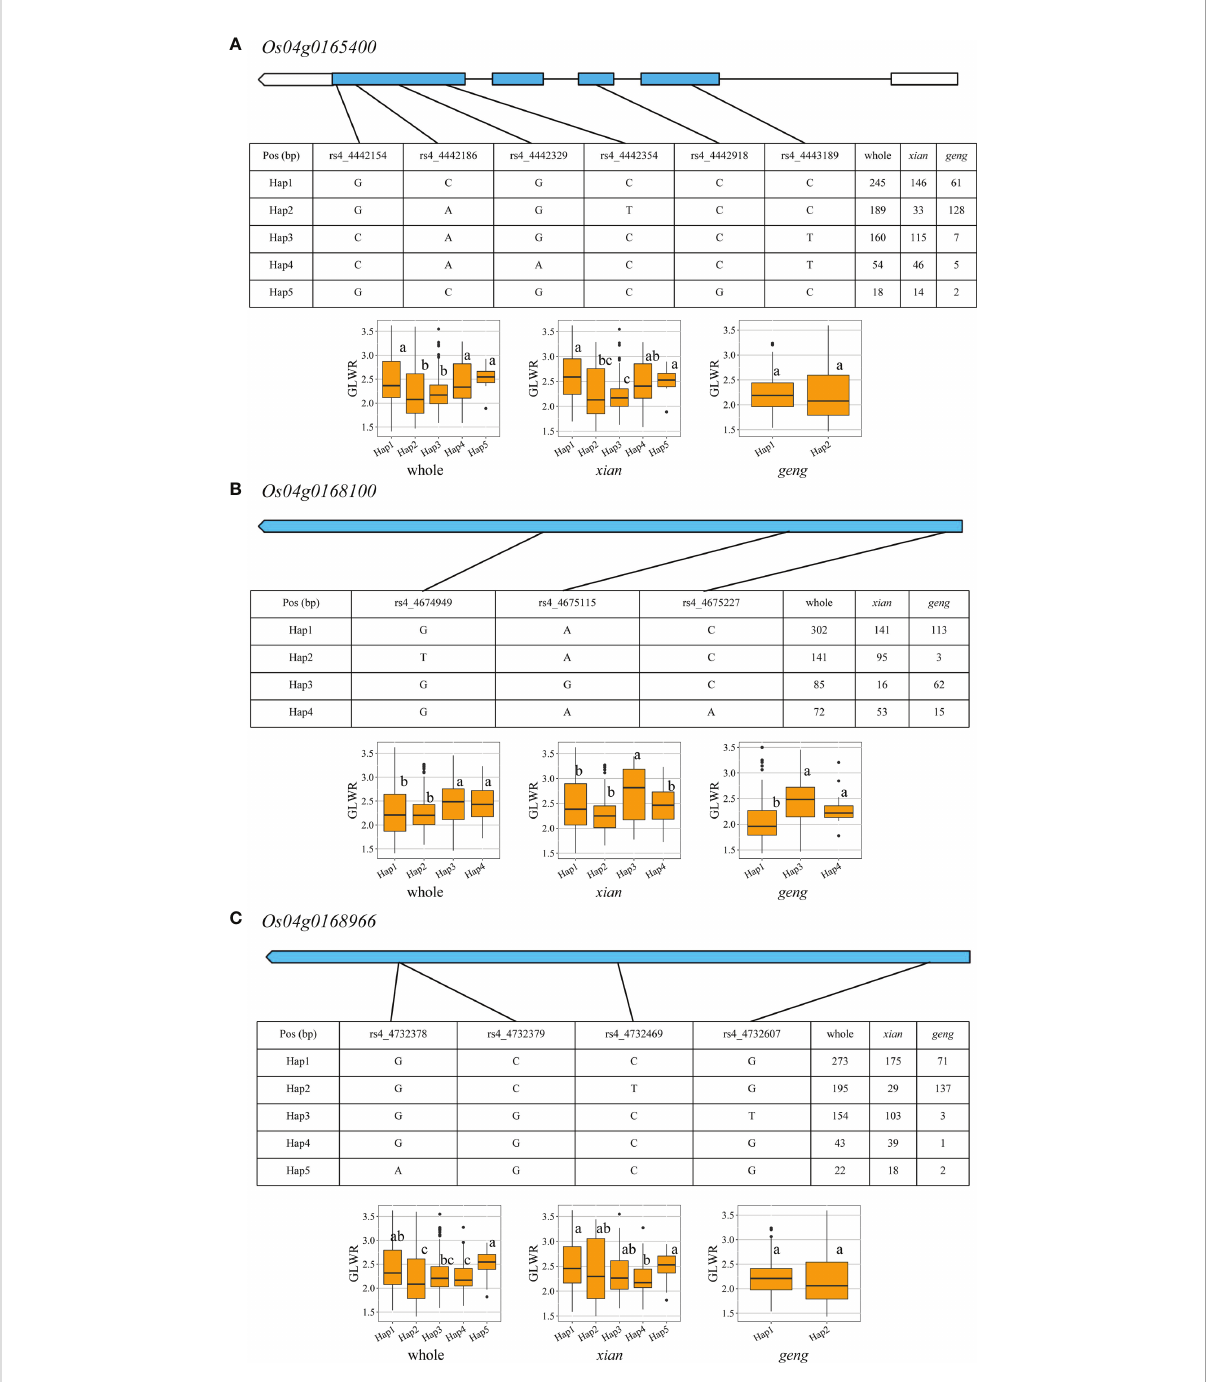
FIGURE 5 Exon-intron structure and haplotype analysis of three candidate genes in whole, xian and geng populations for qGLWR4.1. (A) Os04g0165400 , (B) Os04g0168100 , (C) Os04g0168966 . Different letters indicate signi fi cant differences in trait values among haplotypes by Duncan ’ s test at p <